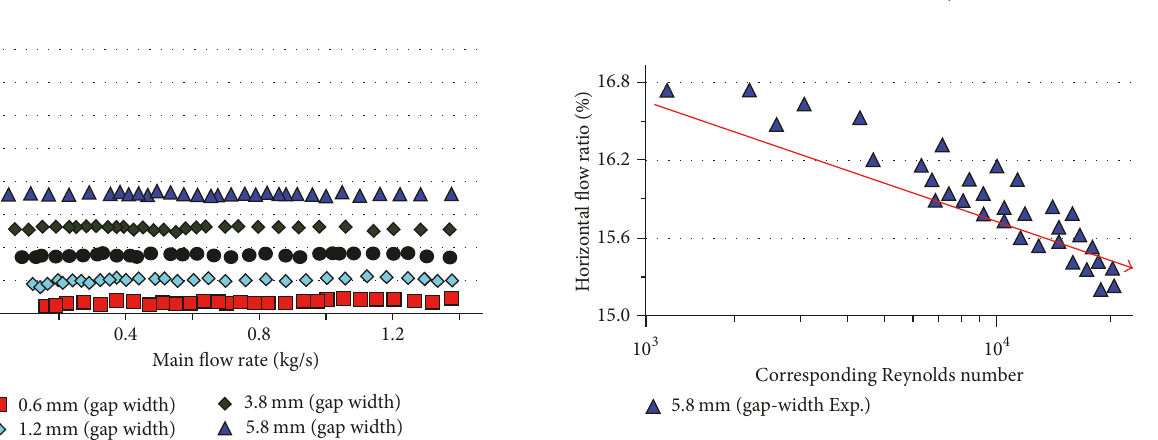
Figure 2: Horizontal flow versus main flow rate.